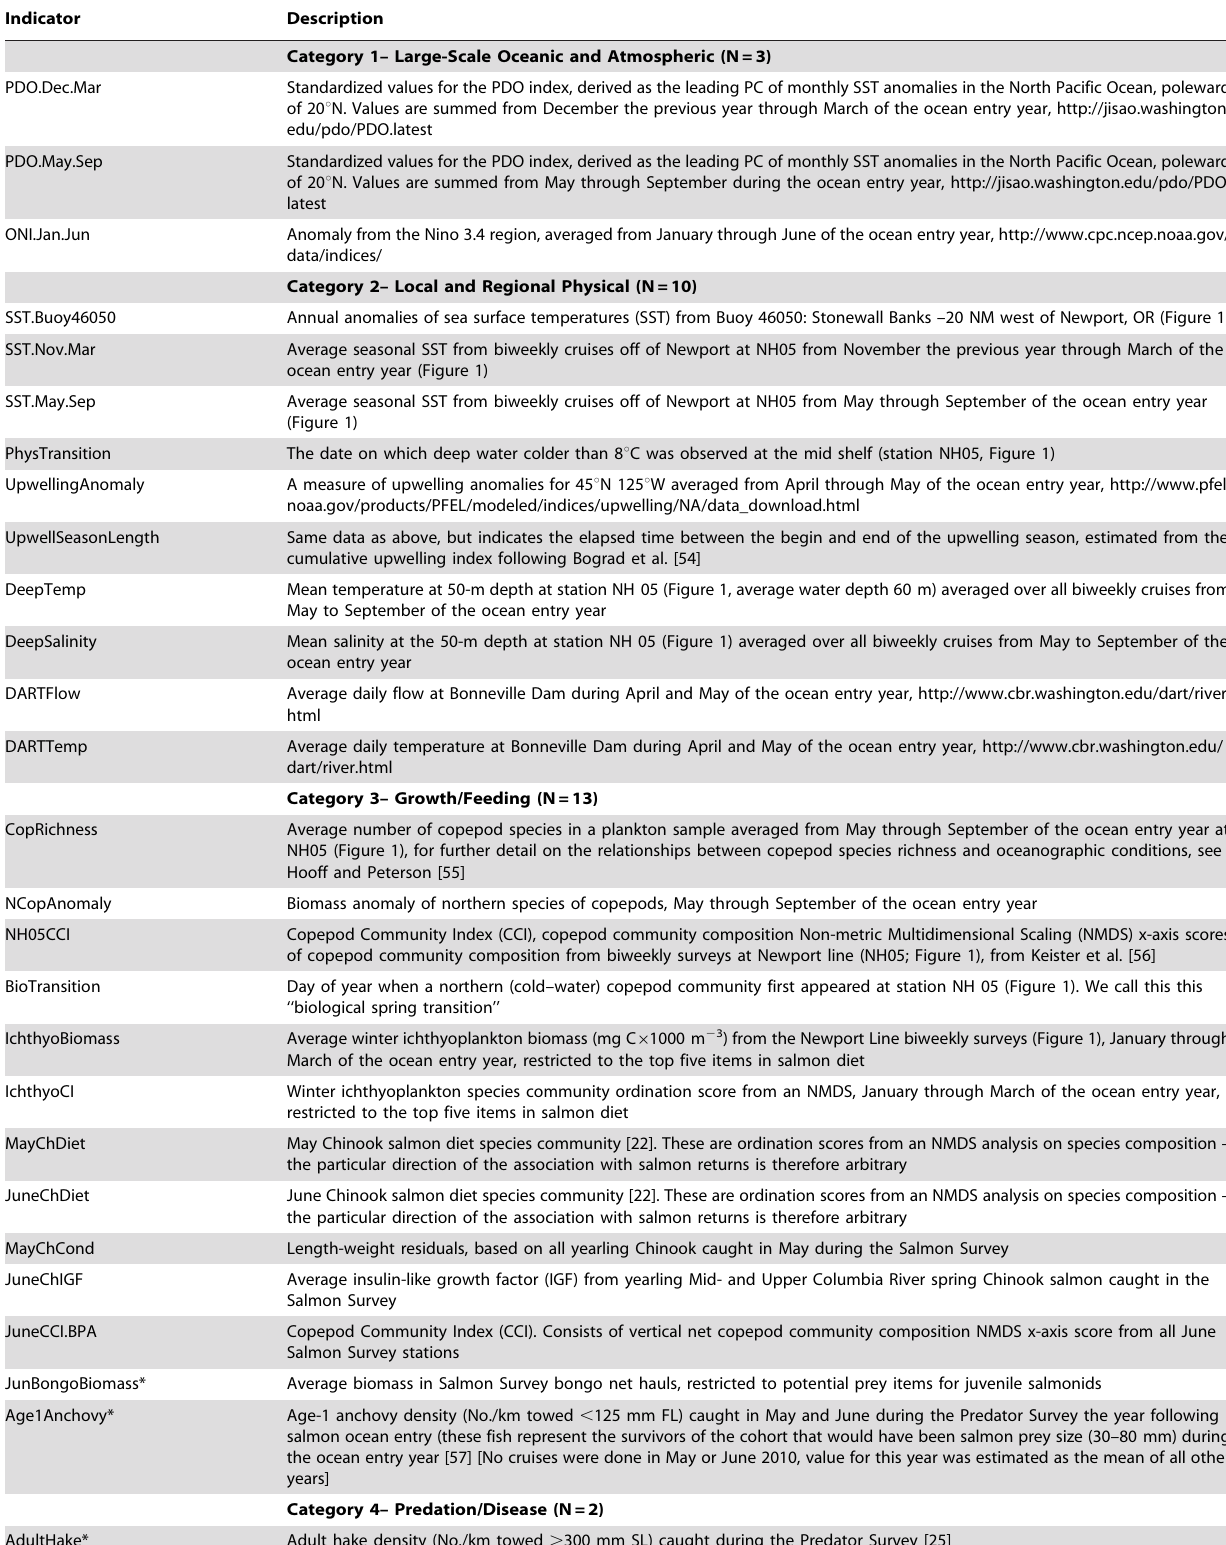
Indicator Description